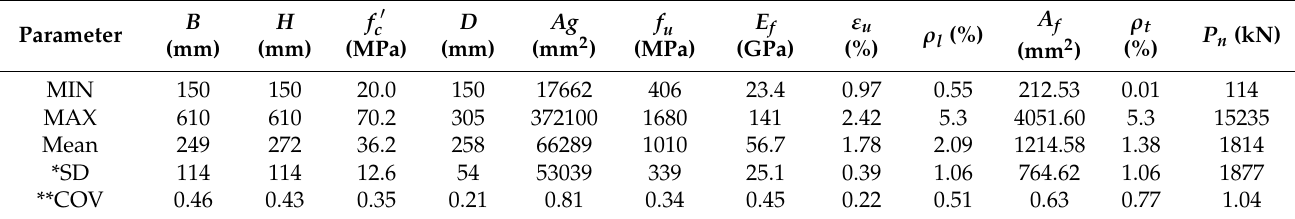
Table 1. Statistical details of different parameters of database.